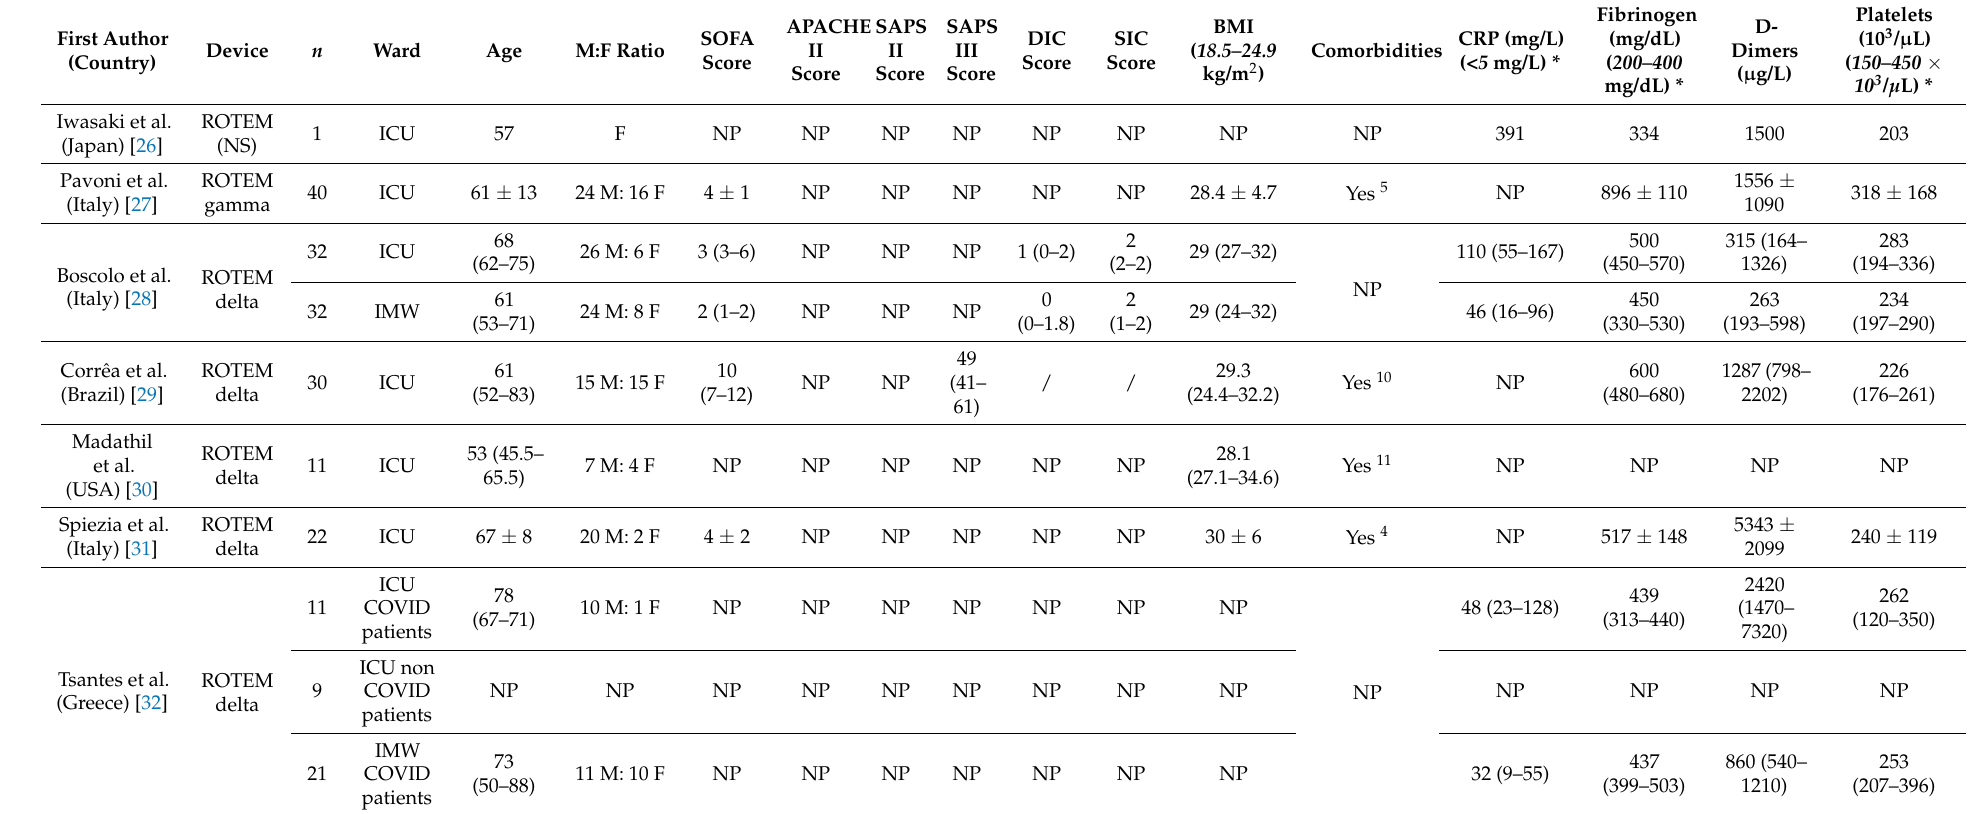
Table 4. Characteristics of the included